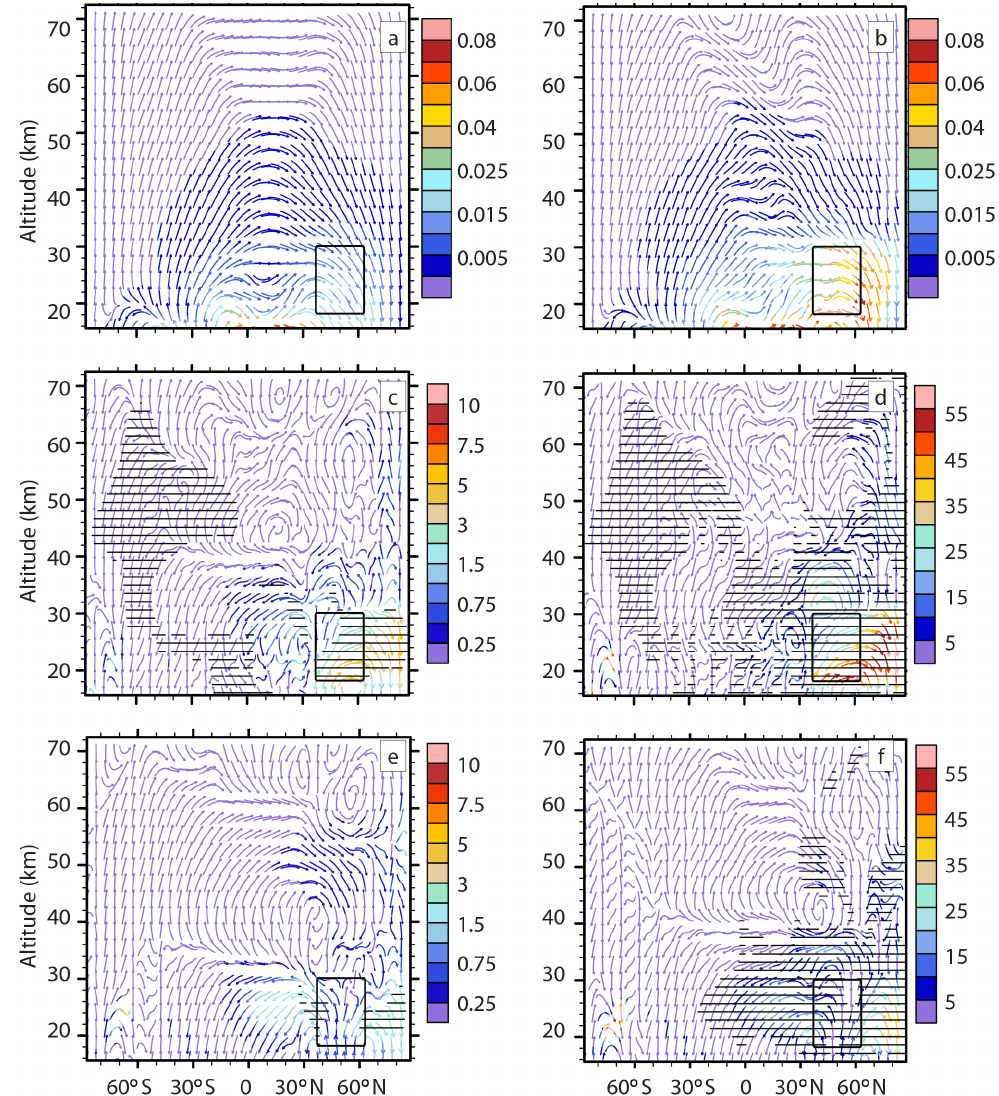
Figure 11. Mean January zonal-mean residual circulation (streamlines for illustration of direction only) and its mass flux (colours, in kgm 2 s − 2 ) on the left (from top to bottom): reference simulation (a) , relative Box0.1–reference simulation anomaly (c) , relative Box0.1– Zon0.1 simulation difference (e) ; and on the right (from top to bottom): snapshot of the SSWbox simulation at 5 days after the GWD injection (b) , 10box–reference simulation relative anomaly (d) , relative 10box–10zon simulation difference (f) . Relative anomalies and dif- ferences are given in % of the reference or corresponding box simulation, respectively. The statistical significance of the mean residual circulation mass flux differences was computed by a t test and regions with p values < 0 . 05 are